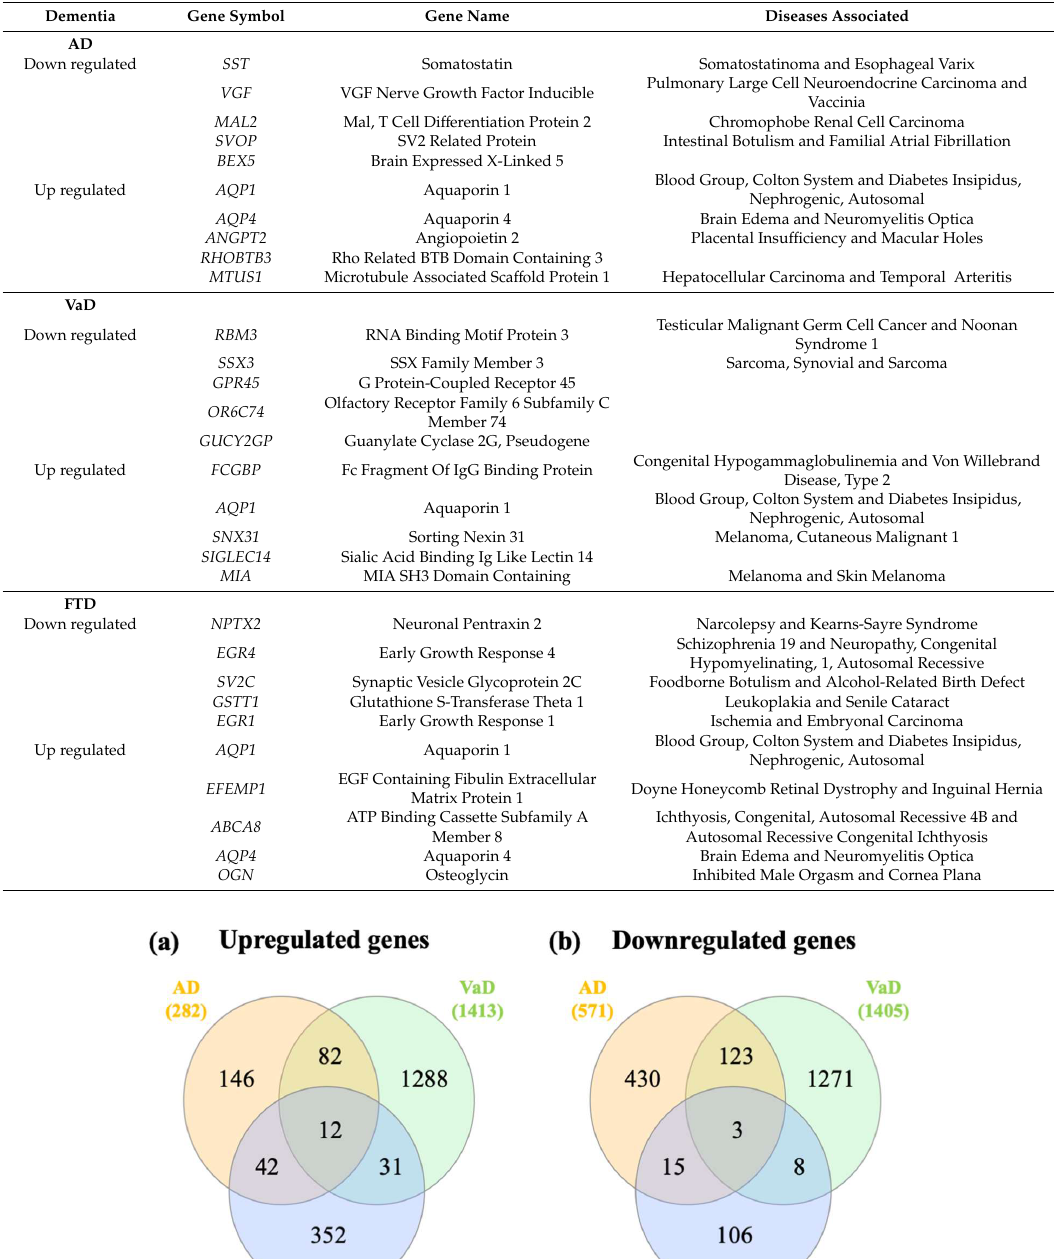
Table 2. The 5 most significant downregulated and upregulated genes for each dementia. Disease associations were obtained from GeneCards website (https: // www.genecards.org / ).